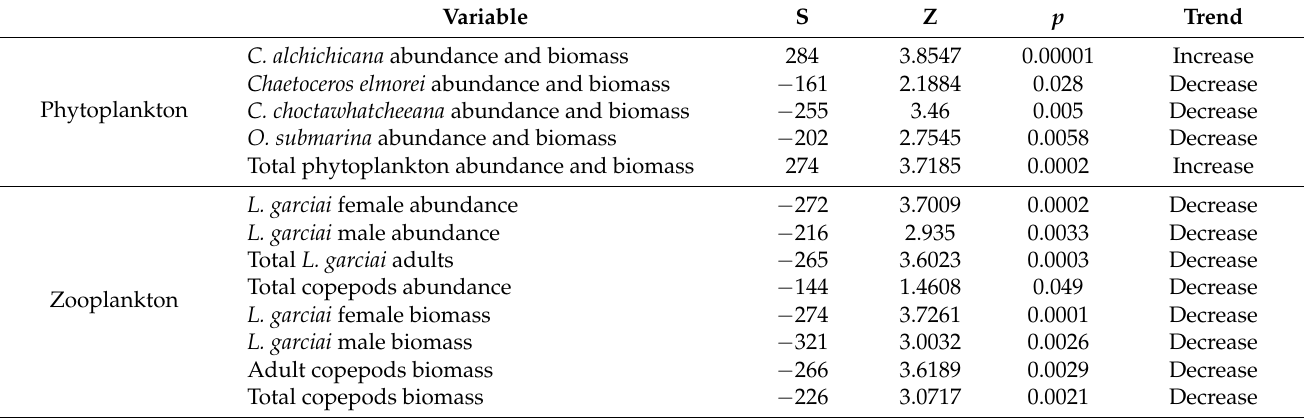
Table 1. Mann–Kendall test results for trend analyses of biological data. (S = Mann–Kendall statistics. Z = normal value for significance determination. p =